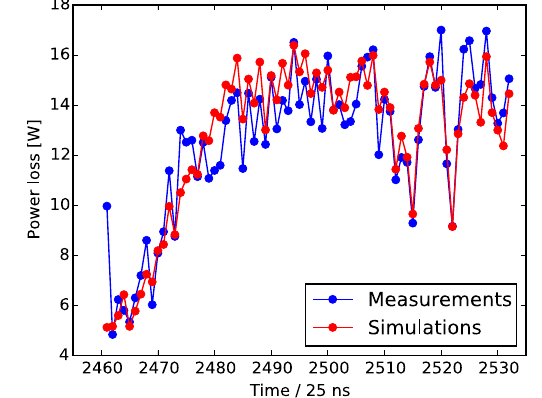
FIG. 16. Bunch-by-bunch energy loss per turn calculated from synchronous phase measurements for a bunch train of 72 bunches spaced by 25 ns (blue circles) and from simulations (red circles) based on the measured beam parameters [5,6]. N ∼ 1 . 0 × 10 11 . Fill 2251